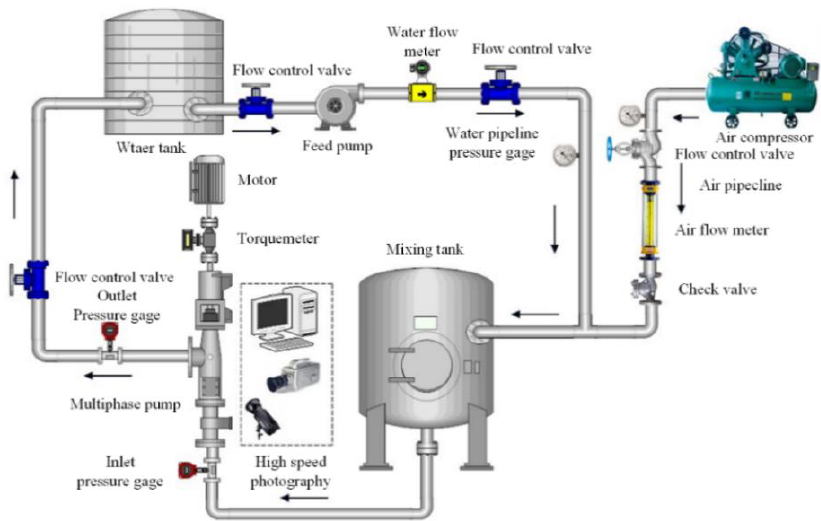
Figure 5. Diagram of multiphase test system. Table 3. Main parameters of multiphase pump.